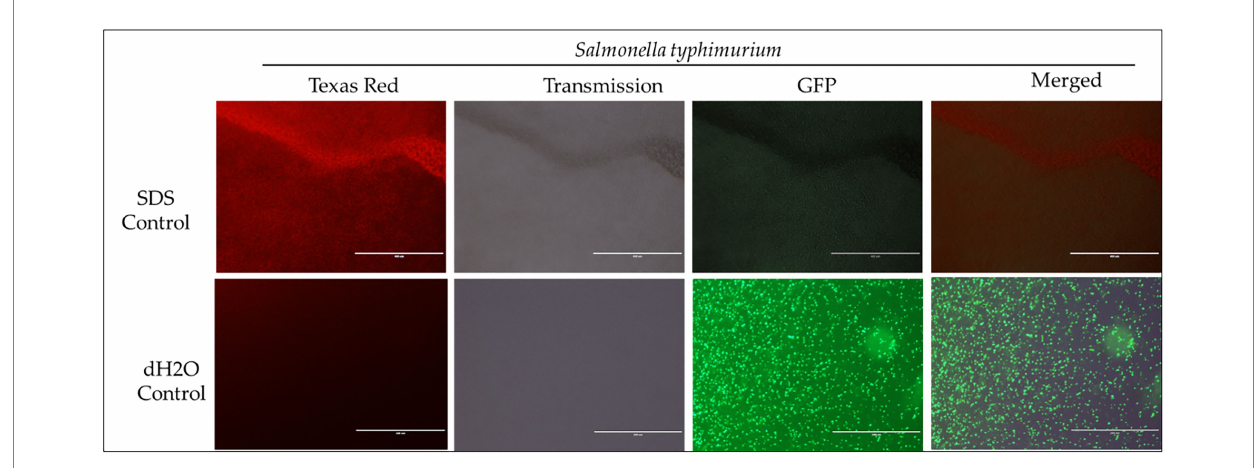
FIGURE 4 Immunofluorescence analysis of S . Typhimurium (ST) treated to 2% SDS as a positive control, while dH 2 O as a negative control. Scale bar = 100 μ m. The immunofluorescence studies reveal that 2% SDS had killed S . Typhimurium (as shown in complete red fluorescence), whereas the dH 2 O revealed live bacteria growing in the sample as indicated by the green